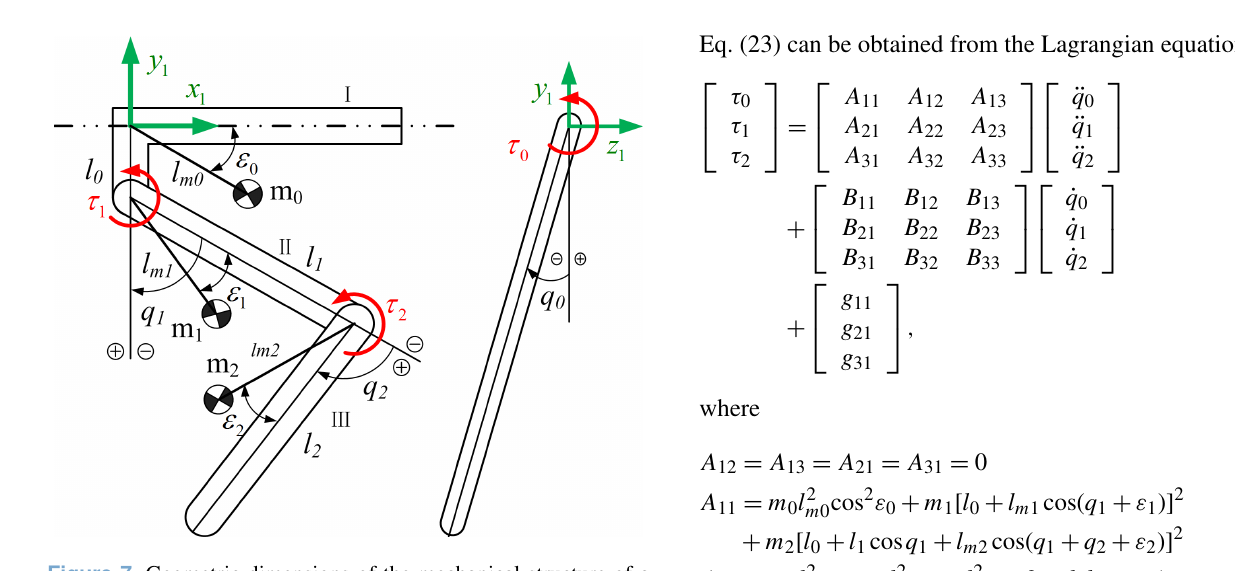
Figure 7. Geometric dimensions of the mechanical structure of a hydraulic four-legged robot support